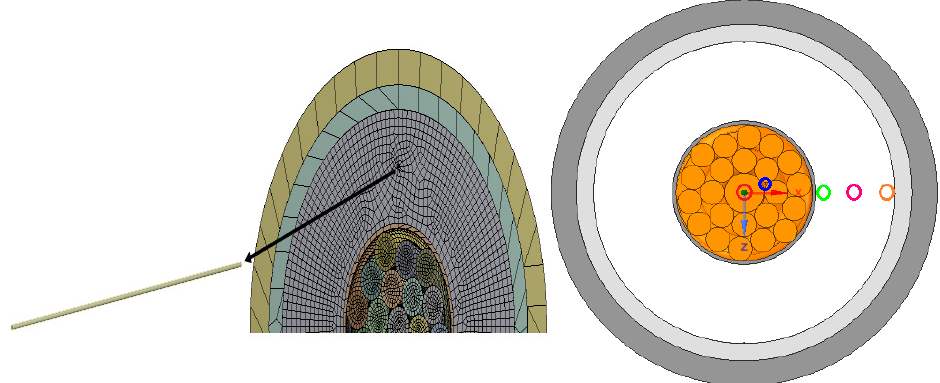
Figure 5. Arrangement of FOS over various different locations within the cable. In Figure 5, different colors of linear-placed FOS are shown. Blue refers to FOS placed parallel to the central wire inside copper. The other colors (pink, green, and orange) are associated with the embedding of FOS within XPLE at various distances from copper.